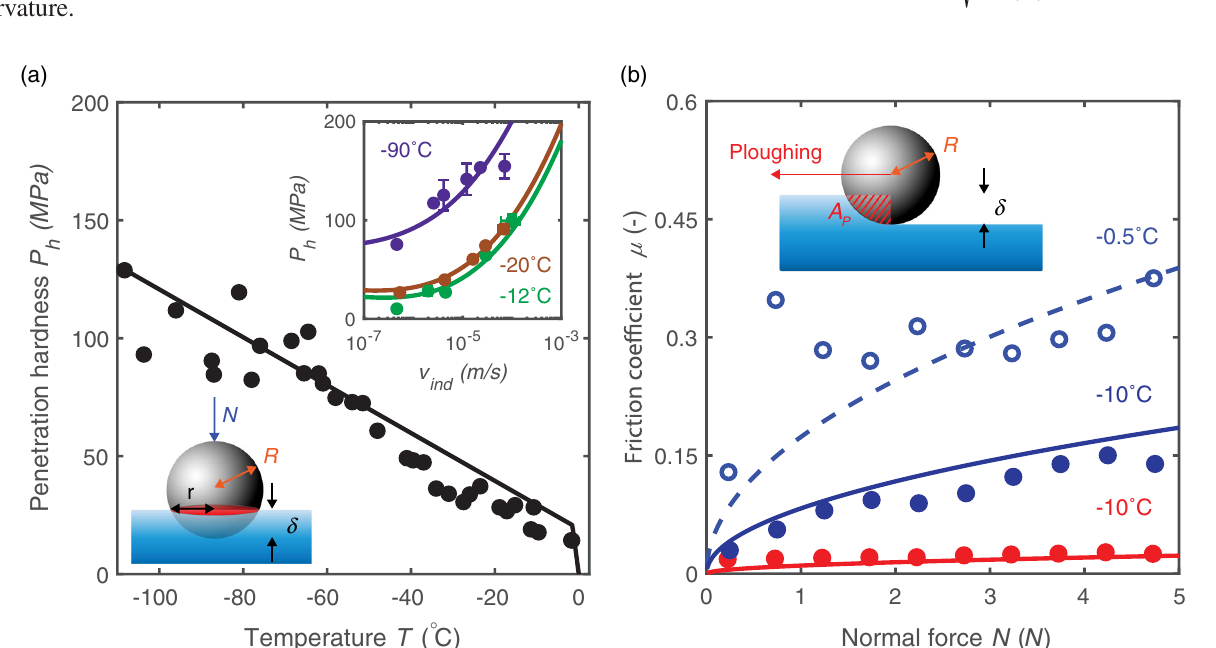
FIG. 2. (a) Penetration hardness P h of ice as a function of temperature, obtained from indentation experiments at a speed of v ¼ 3 . 8 μ m = s. Indentation is performed with a sphere pushed into the ice at various temperatures; see inset (left bottom) for a ind schematic illustration. The indentation depth δ and force N are monitored to calculate the P h . The error bars, defined by the standard deviation in the penetration hardness, are smaller than the symbols used. A linear decrease of P h with temperature is found (black line) up to − 1 . 5 °C when pressure-induced melting sharply decreases the hardness. Upper inset: P h versus v (b) Friction coefficient μ as a function of the normal force N for a small (radius R ¼ 0 . 75 mm, blue open and filled circles) and large ( R ¼ 6 . 00 mm, red filled circles) SiC spherical slider. The ploughing model [lines, Eq. (3)] matches the observed friction coefficient. Inset: schematic illustration of ploughing in ice. The spherical slider of radius R indents the ice in the normal direction with a depth δ and cross section A P